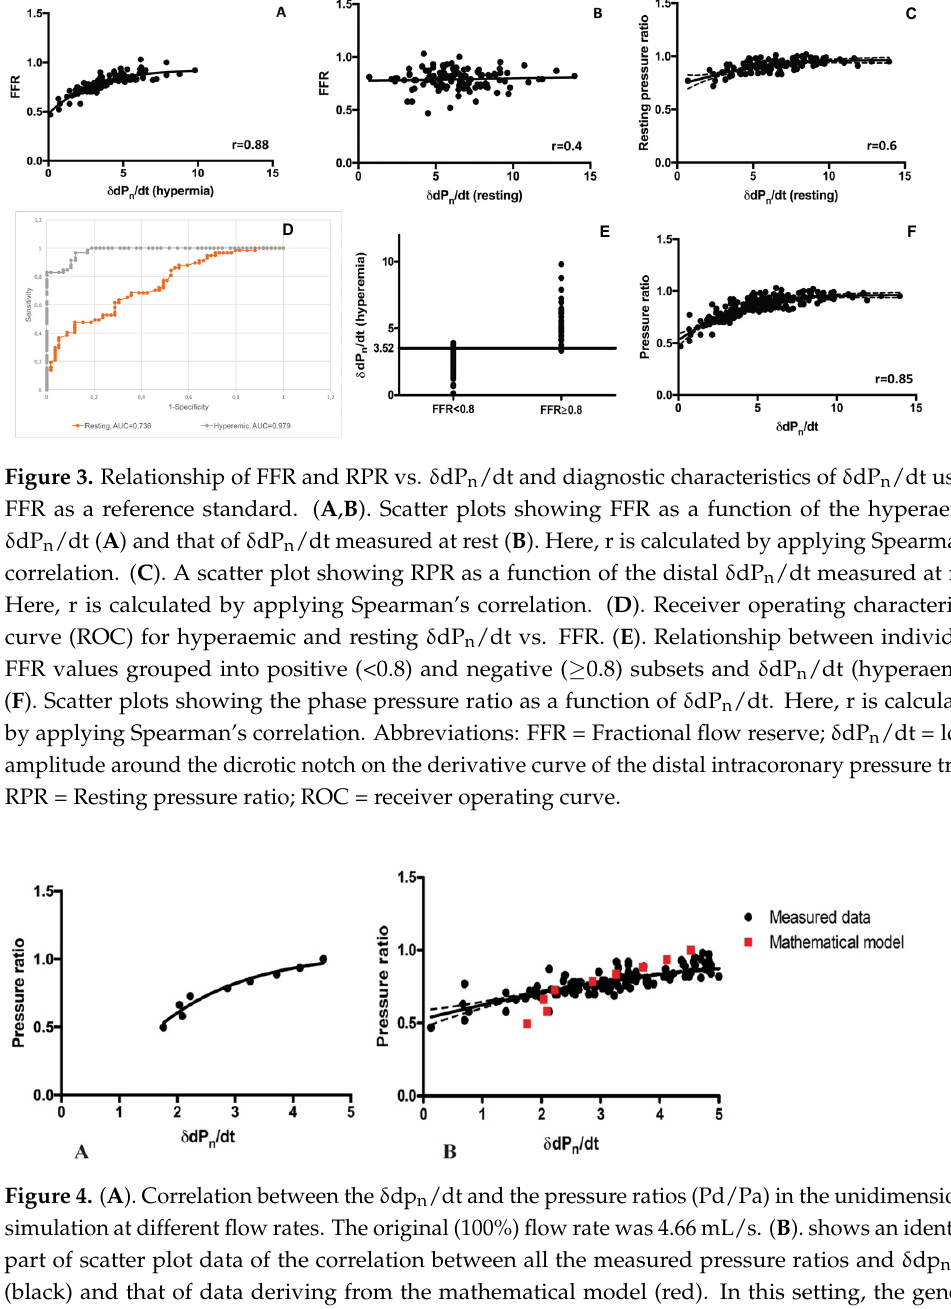
Figure 4. ( A ). Correlation between the δ dp n /dt and the pressure ratios (Pd/Pa) in the unidimensional simulation at different flow rates. The original (100%) flow rate was 4.66 mL/s. ( B ). shows an identical part of scatter plot data of the correlation between all the measured pressure ratios and δ dp n /dt (black) and that of data deriving from the mathematical model (red). In this setting, the general scatter of the modeled data and measured data is quite similar. Abbreviations: δ dP n /dt = local amplitude around the dicrotic notch on the derivative curve of the distal intracoronary pressure trace; Pd/Pa = pressure ratio.